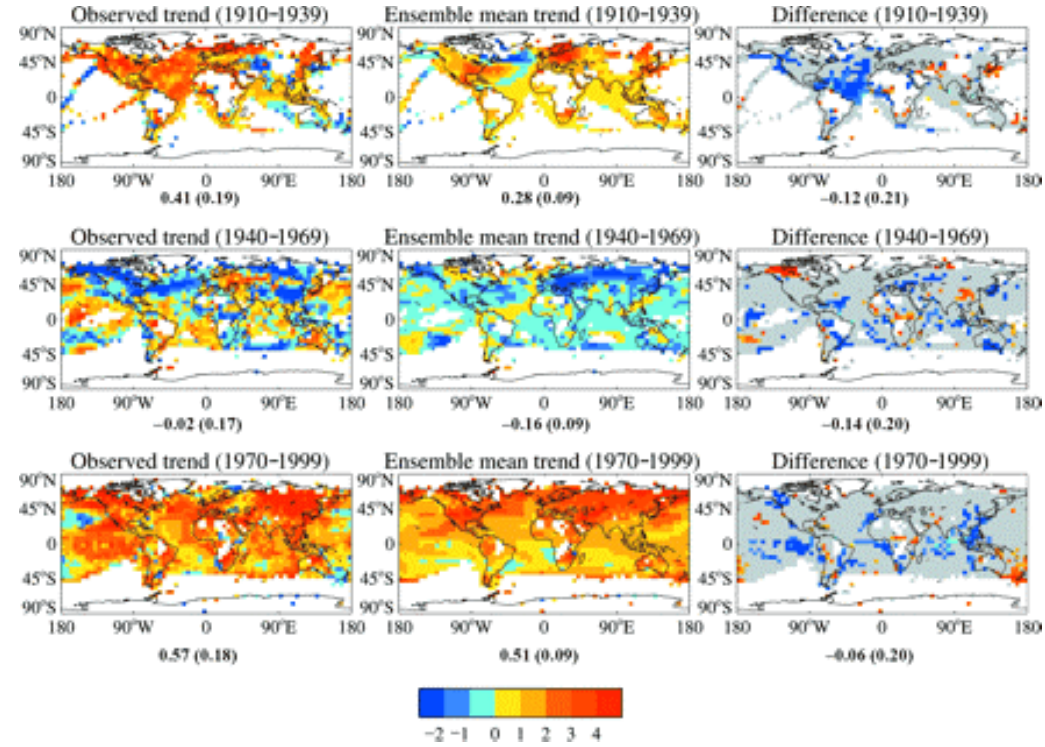
FIGURE 27. Linear trends (°K/30 years) of near-surface temperature for three time intervals (1910–1939, 1940–1969 and 1970– 1999) observations, simulations and their difference across the